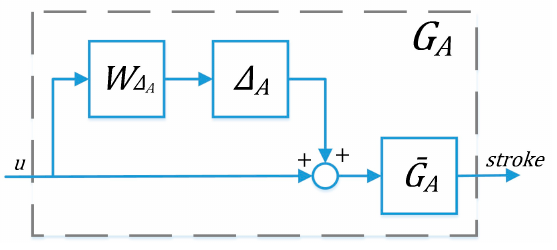
Figure 10. Actuator with input multiplicative uncertainty.